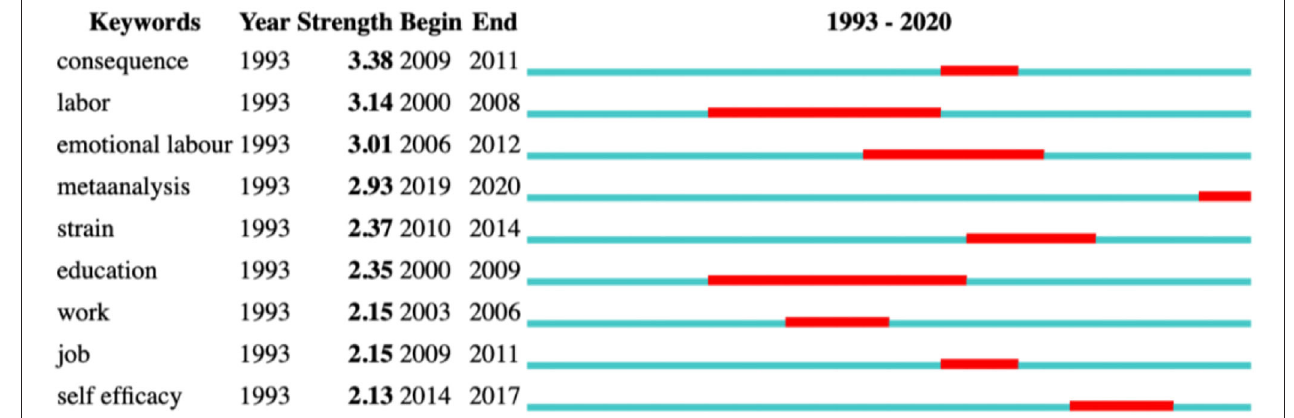
FIGURE 4 | Top 9 keywords with the strongest citation